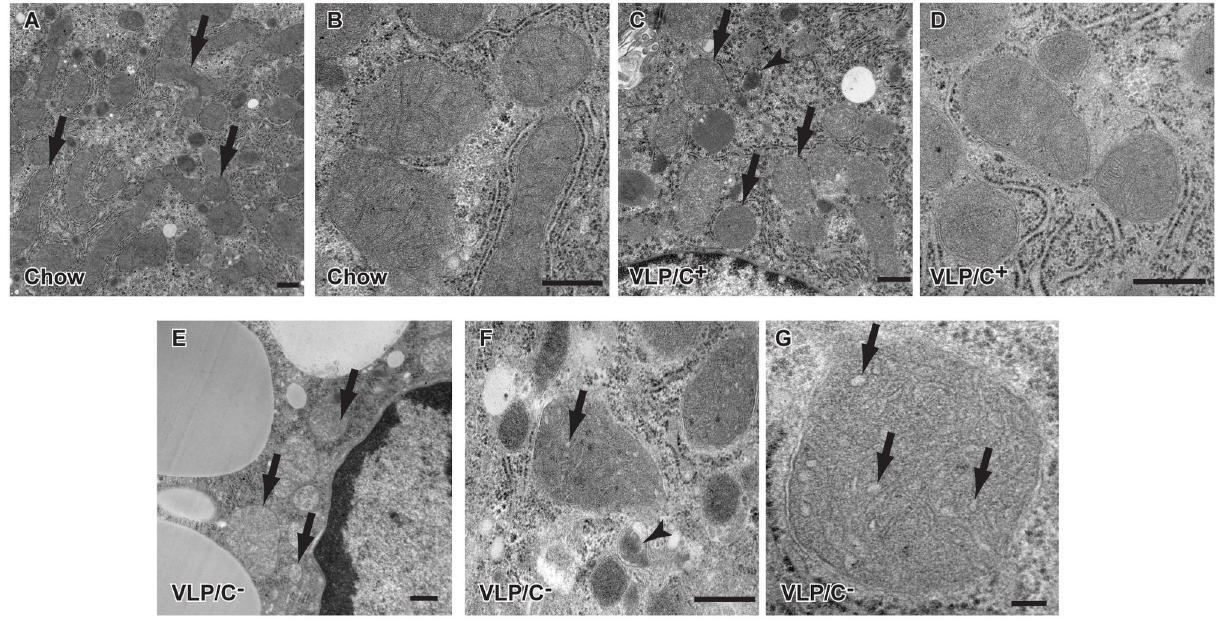
Figure 6. Abnormal mitochondrial ultrastructure in mice fed a choline restricted, very high fat, low protein, very low carbohydrate diet. ( A ) Transmission electron micrograph of hepatocytes from mice maintained for 6 weeks on standard chow reveals normal mitochondrial structure. Arrows, mitochondria. ( B ) Higher power image of mitochondria from mice maintained on standard chow, demonstrating normal cristae. ( C ) Hepatocyte mitochondria from livers of mice maintained on VLP/C + exhibited normal cristae folding and evident double membranes. Sparse microvesicular lipid droplets were also evident (white circular structure). Arrows, mitochondria; arrowhead; autophagosome. ( D ) Higher power image of hepatocyte mitochondria from mice maintained on VLP/C + , showing morphology of the cristae. ( E ) VLP/C - diet induces massive hepatocyte steatosis (note large circular pale fat droplets), and swollen mitochondria with disorganized and dilated cristae. Hepatocyte nucleus is on the right side of the image. Arrows, mitochondria. ( F ) Higher power image of hepatocyte mitochondria from mice maintained on VLP/C - , with dilated cristae (arrow) and an autophagosome (arrowhead). ( G ) High power image of hepatocyte mitochondria from mice maintained on VLP/C - , with dilated cristae (arrows). Scale bars, 500 nm ( A – F ), 100 nm ( G ). doi: